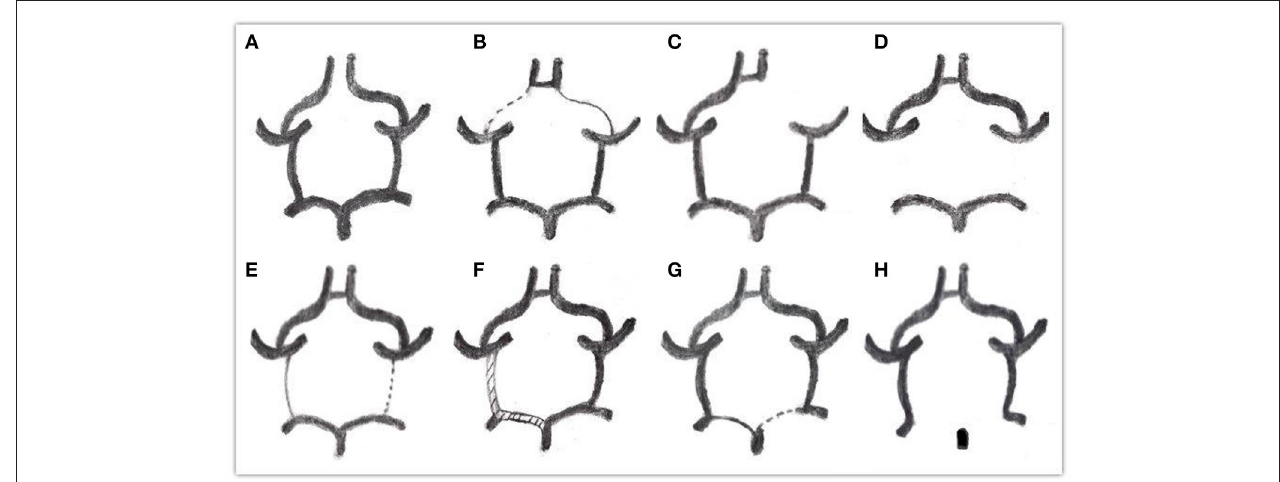
FIGURE 1 | Classification of the circle of wills. (A–H)